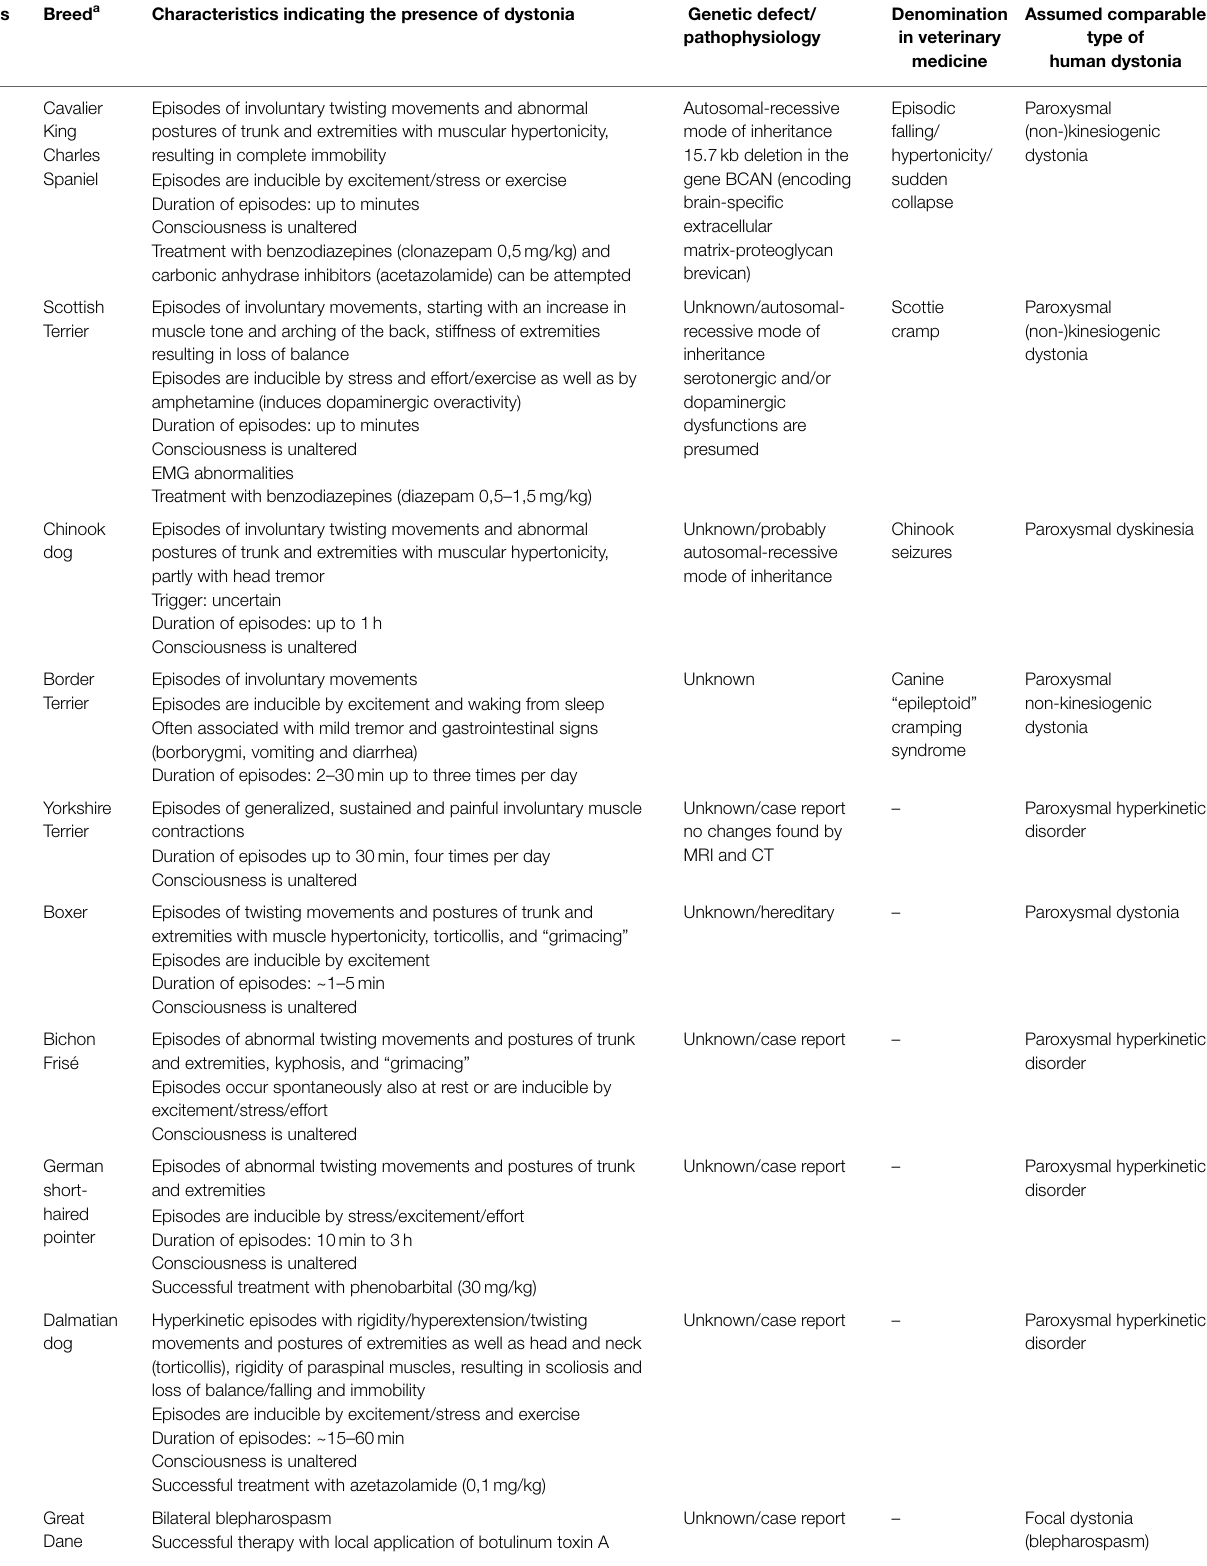
TABLE 5 | Hyperkinetic disorders in domestic animals, possibly including dystonic signs .